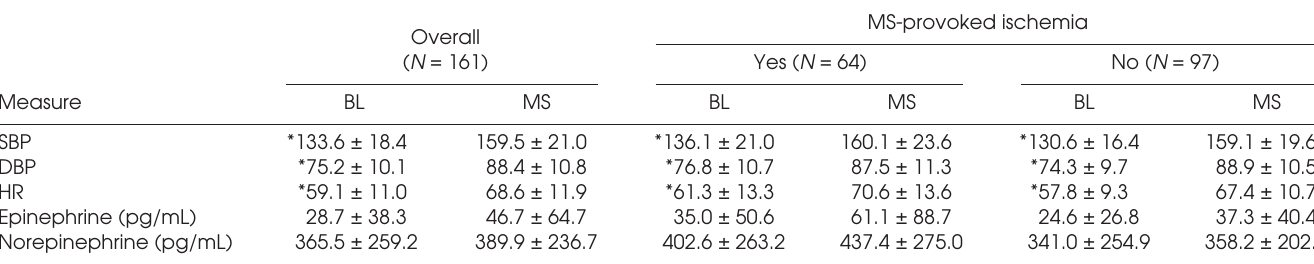
Table 2. Physiologic response to